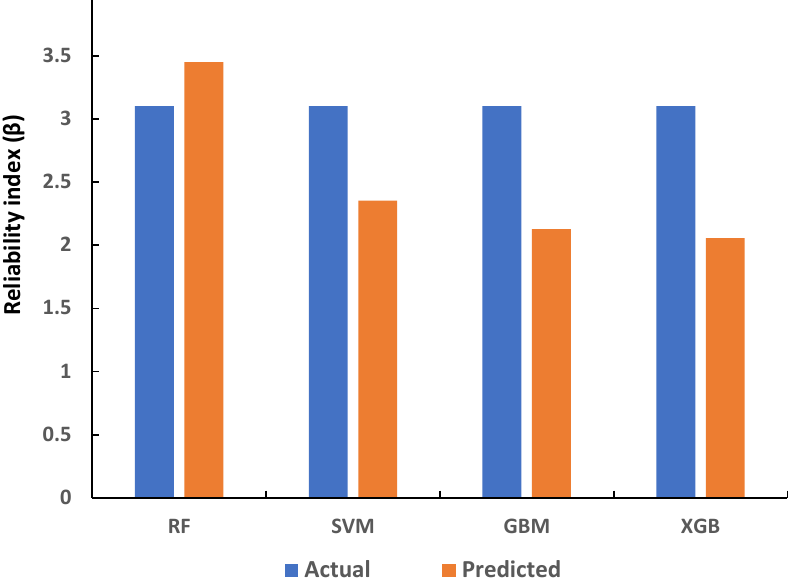
Figure 15. Reliability index value comparison of actual and predicted models for training datasets.